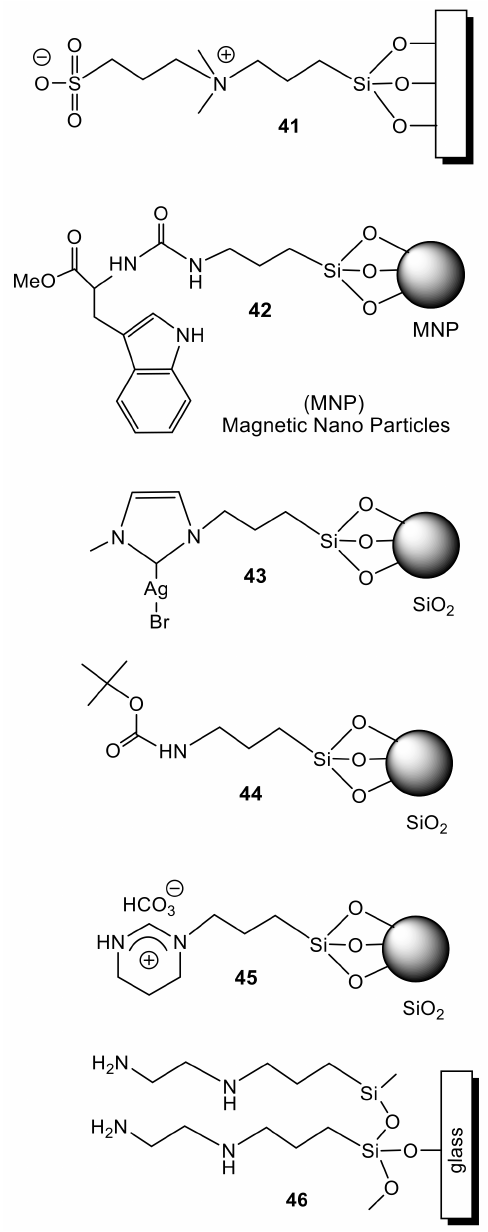
Figure 12. Chemical structures of silatranyl surfaces ( 41 – 46